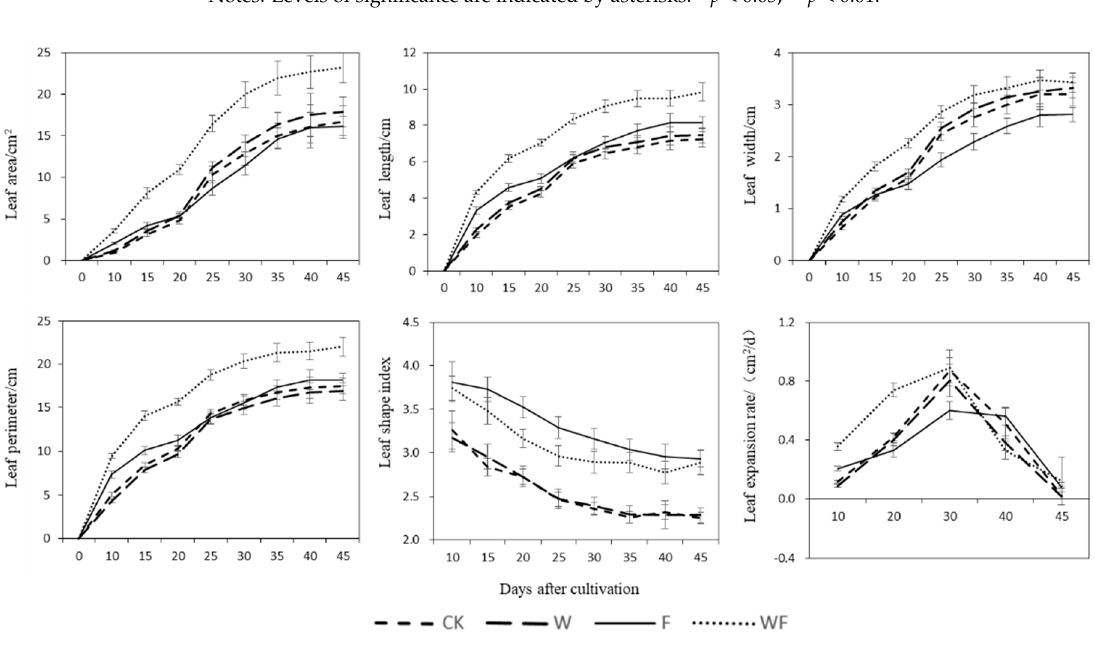
Figure 2. Dynamic changes of leaf area, leaf length, leaf width, leaf perimeter, leaf shape index, and leaf expansion rate of the four